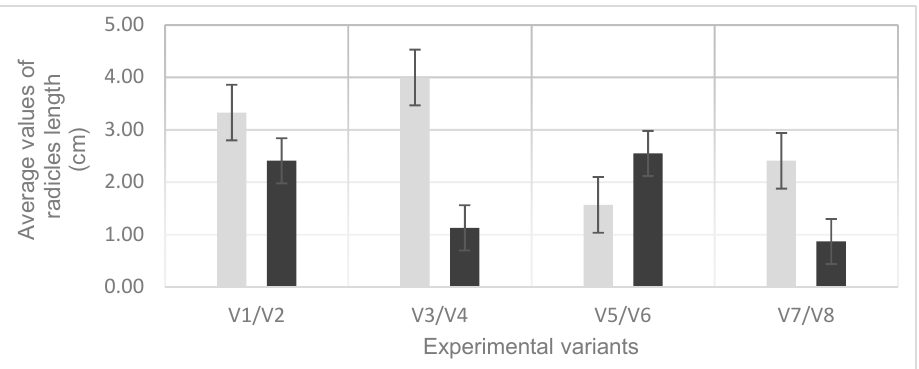
Figure 2. The medium values of radicles’ length of Lepidium sativum L. sprouts on gauze (V1 control, illuminated sunlight; V3, illuminated with white LED; V5, illuminated with blue LED; and V7, illuminated with red LED experimental variant) or biochar (V2 control, illuminated sunlight; V4, illuminated with white LED; V6, illuminated with blue LED; and V8, illuminated with red LED experimental variant). Data acquired from the experiment were statistically investigated and were expressed as the mean ± SD (standard deviation). Bars are one standard deviation.